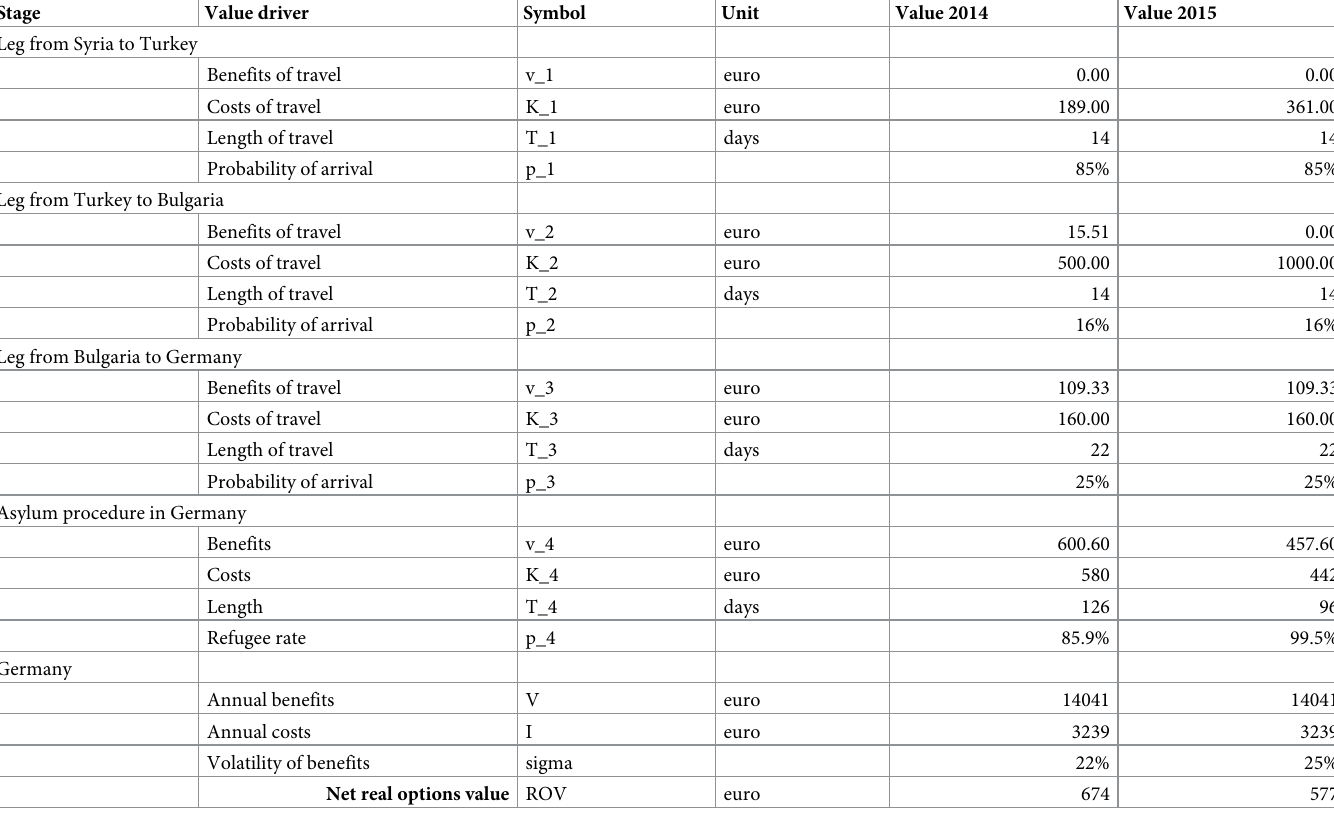
Table 3. Value drivers and real options value for Eastern Mediterranean Route by land in 2014 and 2015. Stage